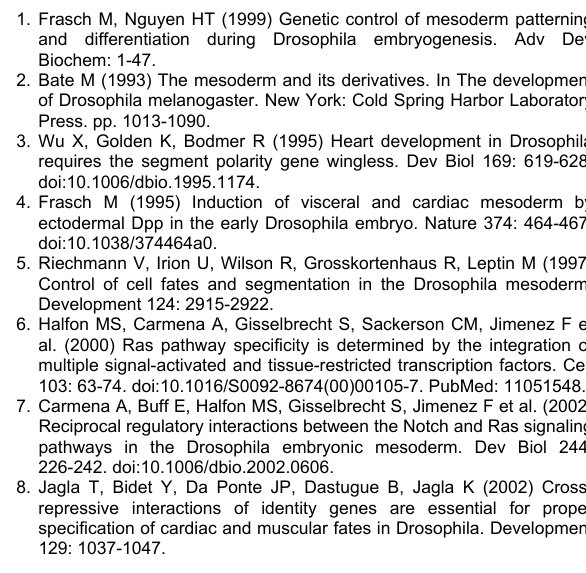
Figure S3. Heart phenotypes observed after mesodermal overexpression of individual members of the Iro-C. (A, E, I) Wild-type expression of Eve (A), Odd (E) and Tin (I). (B, F, J) Overexpression of Ara results in (B) the loss of some Eve clusters, (F) a mild disorganization of Odd-expressing pericardial cells and (J) a mild disorganization of Tin-positive cells. The ectopic accumulation of Tin-expressing cells at